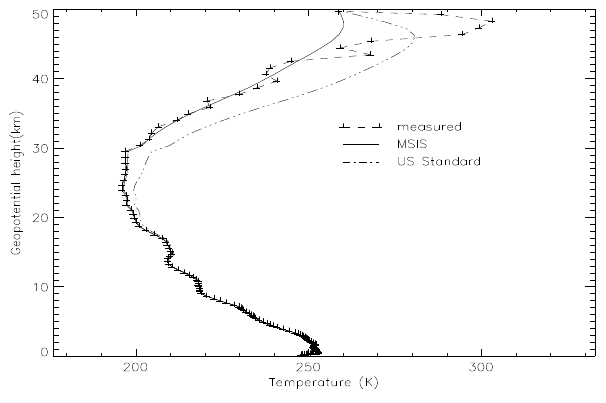
Fig. 11. The sensitivity of the temperature retrievals to the assumed climatology, using ‘95-07-01-06:22met-gps16’